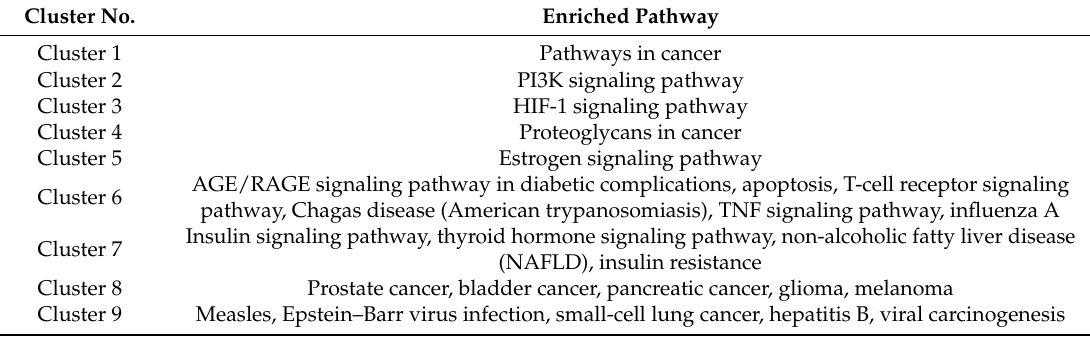
Figure 6. Clustergram of pathways. Rows and columns represent the pathways and input genes, respectively. The enriched terms in the rows of the heat map are clustered by the similarity of the gene contents. The input genes in the column are sorted in descending order of the sum of the columns from left to right. The colors of the boxes represent each cluster. Table 2. Cluster of the enriched pathway. PI3K—phosphatidylinositol 3-kinase; HIF-1—hypoxia- inducible factor 1; AGE—advanced glycation end products; RAGE—receptor for AGE; TNF—tumor necrosis